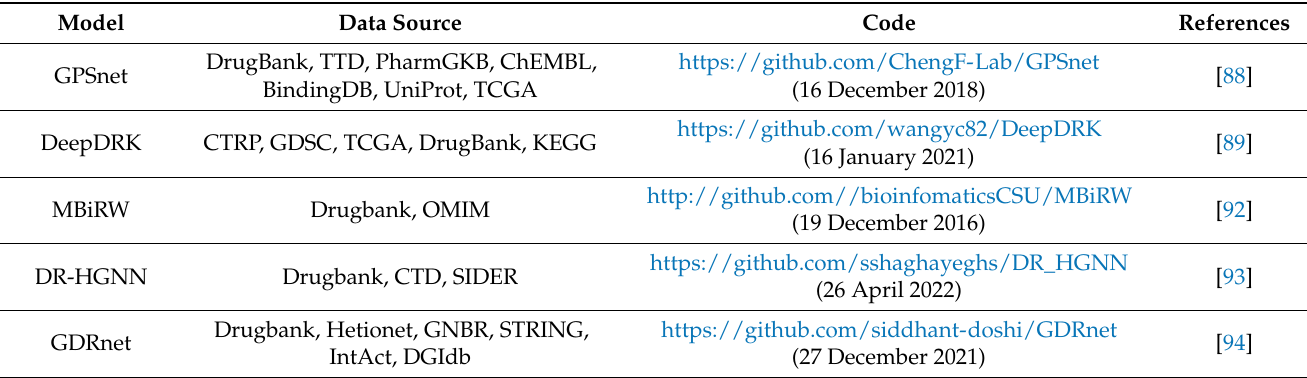
Table 5. Methods for anti-cancer drug repurposing based on artificial intelligence.